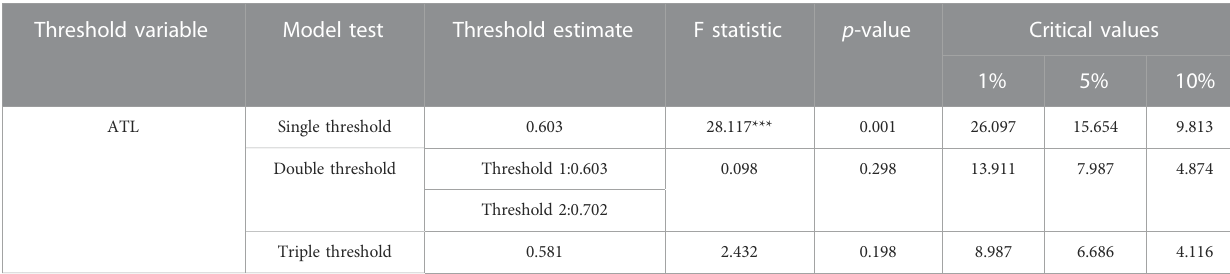
TABLE 12 Threshold effect